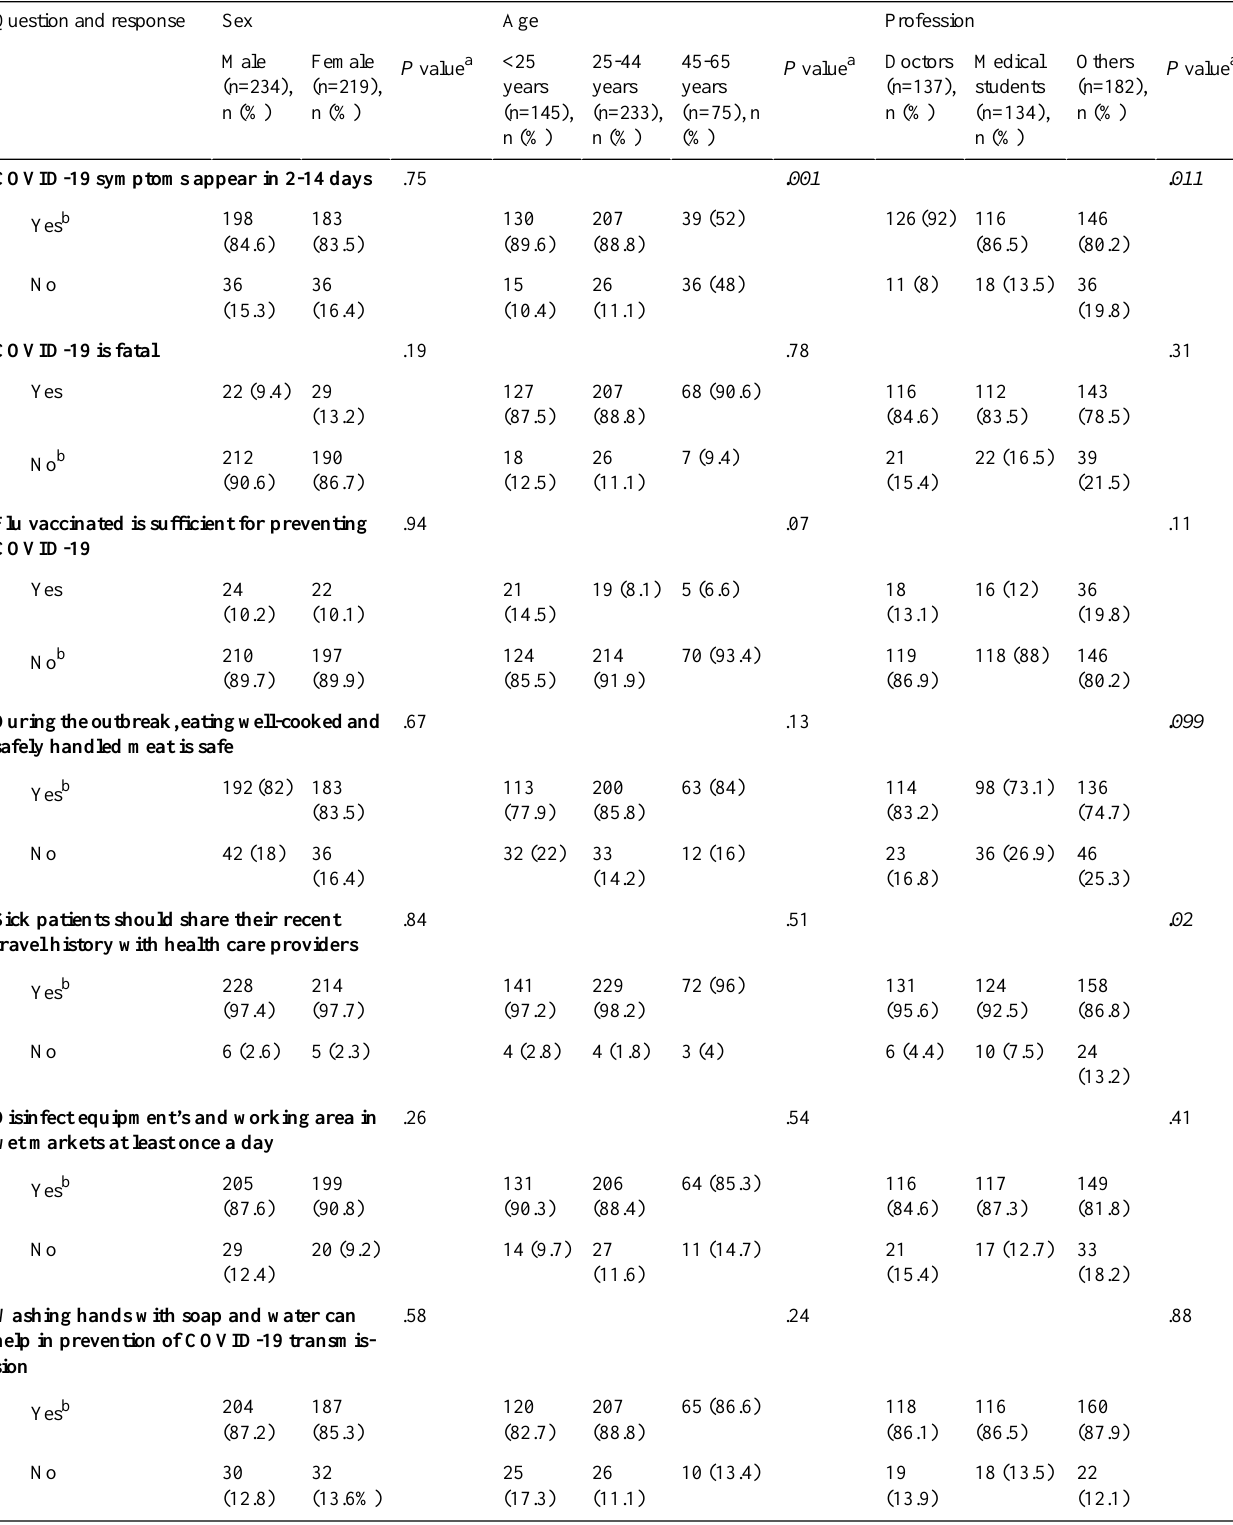
Table 5. Association between respondent characteristics and perceptions of coronavirus disease 2019 (COVID-19). ProfessionAgeSexQuestion and